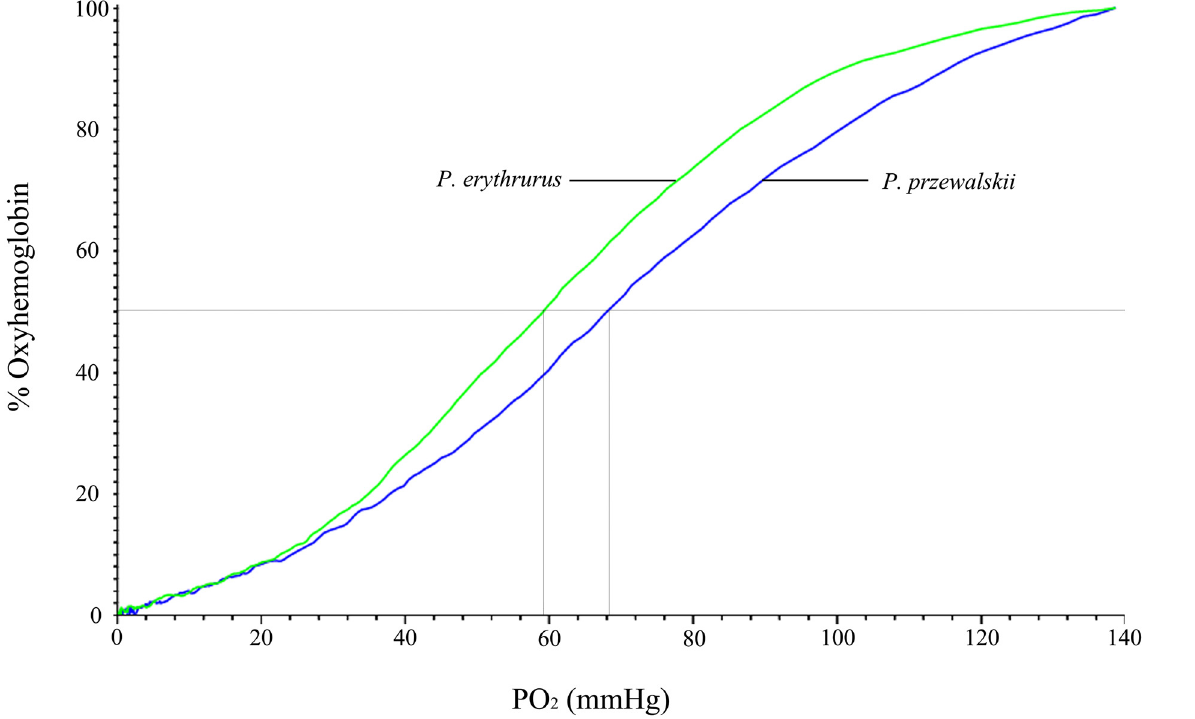
Fig 1. Whole blood oxygen dissociation curves of P . erythrurus (green line) and P . przewalskii (blue line) at 30°C and pH 7.3.